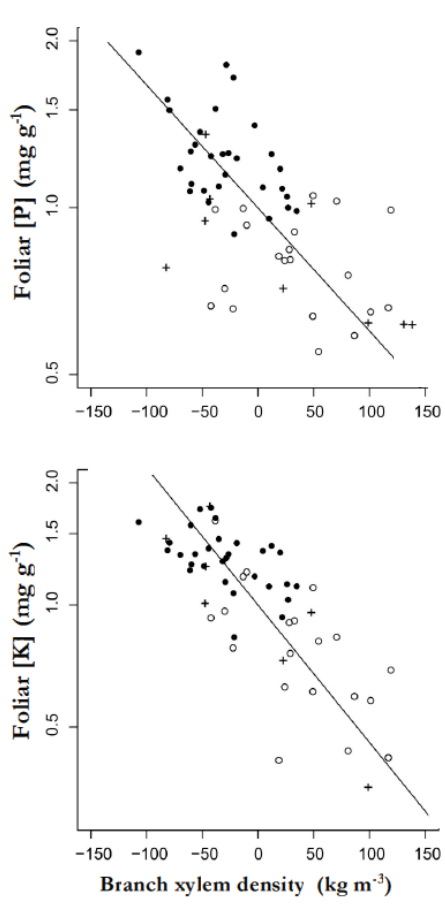
Fig. 8. Standard Major Axis (SMA) regression lines between the derived environmental components of branch xylem density ( ρ x ) and foliar [P] and foliar [K]. Open circles indicate species found on low fertility sites and the closed circles indicate species found on Fig. 8. Standard high fertility sites. Species found on both soil fertility groups are Major Axis (SMA) regressions lines between the derived environ- designated by a “+” (see text for details). Solid lines show the SMA model circles indicate species found on low fertility sites and the close circles indicate species found on high fertility sites. Species found on both soil fertility groups are designated by a “+” (see text for details). Solid lines show the SMA model fits.